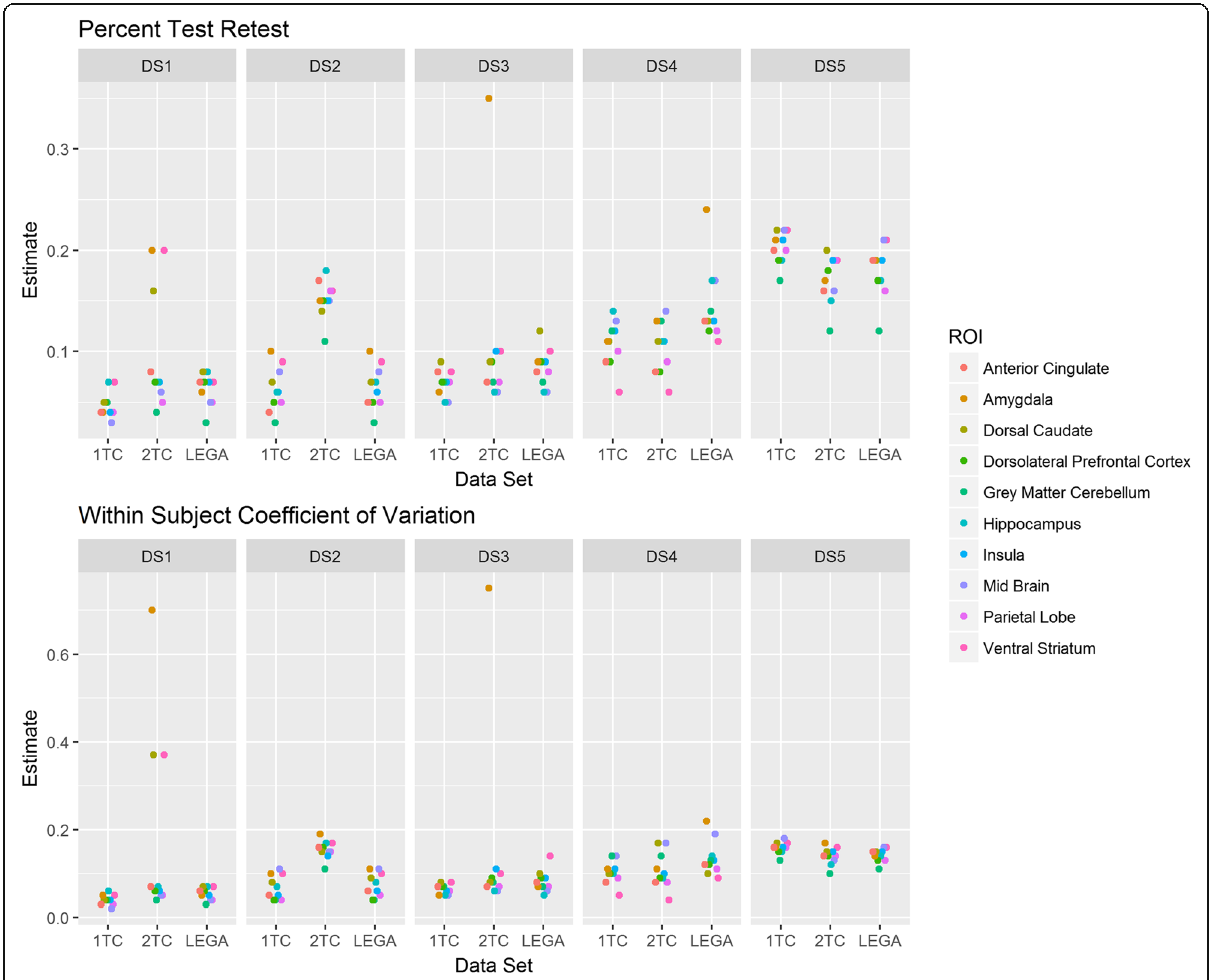
Fig. 1 Percent test-retest (PTRT, upper panel) and within-subject coefficient of variation (WSCV, lower panel) across the considered datasets. Each point in the plot, for a given dataset, represents a particular region of interest (ROI) so that the plot represents the variability of PTRT or WSCV across the considered ROIs. For each data set, DS1, DS2, DS3, DS4, and DS5, there were three quantification methods investigated (1, 2, and L denote one-tissue compartment model, two-tissue compartment model, and likelihood estimation in graphical analysis,